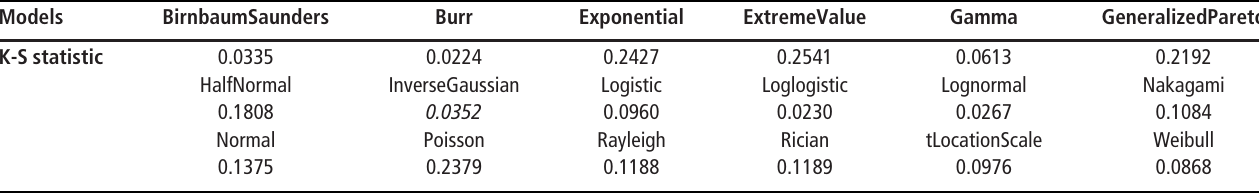
Table 5 Statistical results for different distribution models (AD4CHE data set) Models